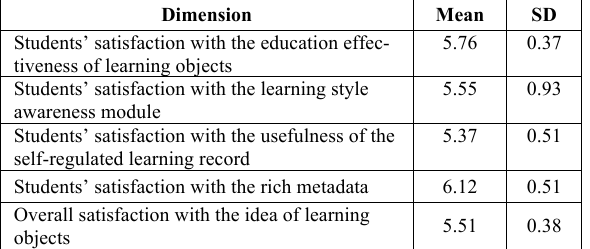
TABLE IV. T HE RESULT OF S TUDENTS ' S ATISFACTION Q